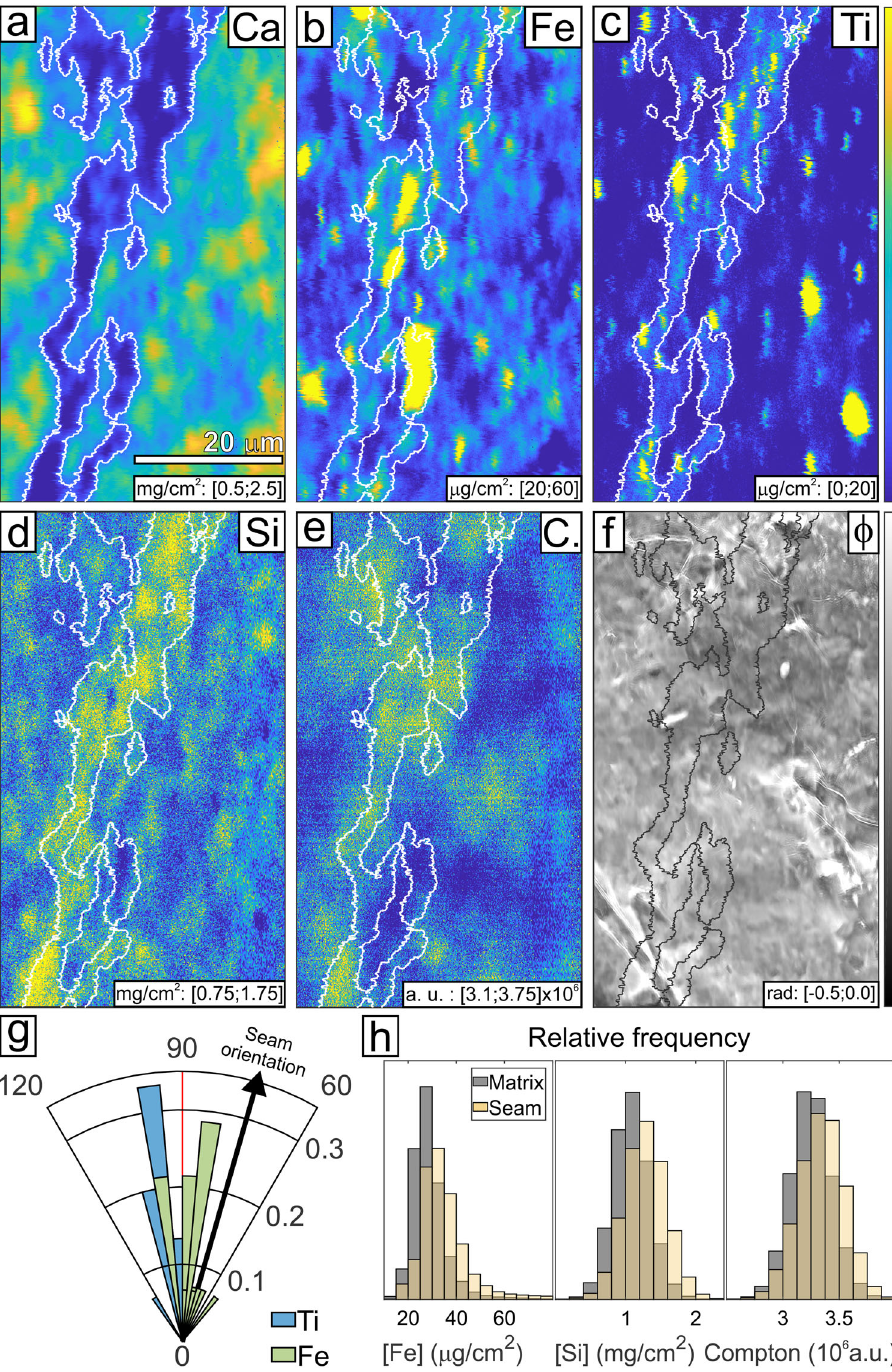
Fig. 5 Nano-scale chemical and structural maps of an individual micro-dissolution seam. a XFM Ca map of a micro-dissolution seam from Sample B and its immediate surroundings. Seam boundaries obtained with automated segmentation (see the “ Methods ” section) are marked with white lines. The maps in ( b ) – ( f ) have the same scale. b Fe map, c Ti map, d Si map, and e Compton scattering map for the same area shown in ( a ). Fe, Ti, and Si are enriched within the seam. The XFM map of Compton scattering intensity (arbitrary units) demonstrates higher intensity within seams, indicating a density increase. f Nano-scale ptychographic map of the phase (in radians) of the complex X-ray wave fi eld exiting the sample. The micro-dissolution seam does not display a marked structural difference in comparison to the micritic matrix. g Polar plot of the relative long-axis orientation-frequency distribution of Fe- and Ti-rich phases mapped in ( b ) and ( c ). Long-axis orientation was determined from best- fi t ellipses to Fe particles with concentrations ≥ 50 μ g/cm 2 and Ti particles with concentrations ≥ of 15 μ g/cm 2 . To minimise discretization errors, phases made of <30 pixel and with aspect ratios <2 were disregarded. Most phases are aligned with bedding (vertical red line) within ±5°. h Histograms of the relative concentration frequency distributions of Fe and Si as well as Compton- scattering intensity, respectively, demonstrate that dissolution seams exhibit elevated magnitude of these quantities. The XFM maps and ptychogram used to make this fi gure are provided in Supplementary Data 4.